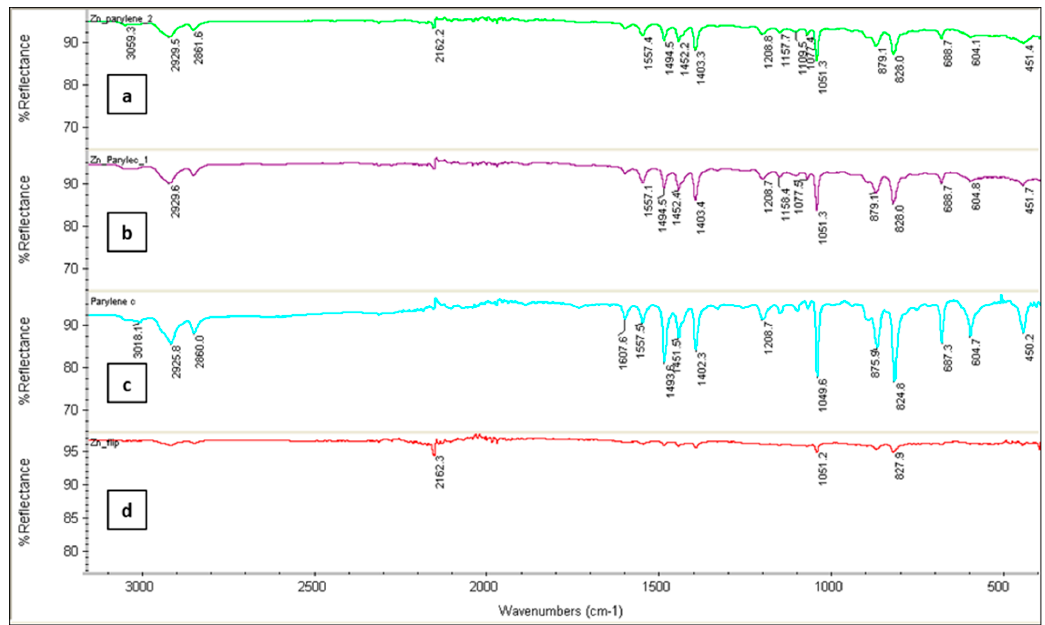
Figure 9. FTIR spectra of: ( a ) Parylene C-coated Zn stent on random spot 1; ( b ) Parylene C-coated Zn stent on random spot 2; ( c ) Pure Parylene C sample; ( d ) Uncoated Zn stent.